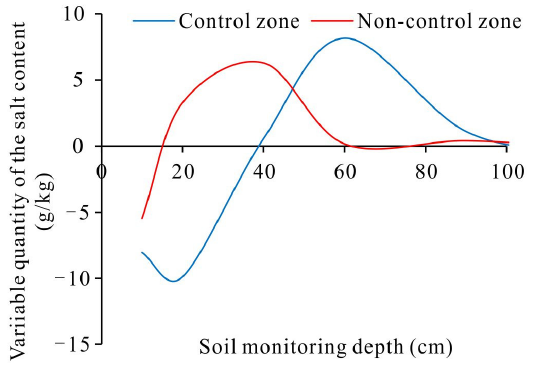
Figure 6. Contours of groundwater depth under the in fl uence of the groundwater control system.